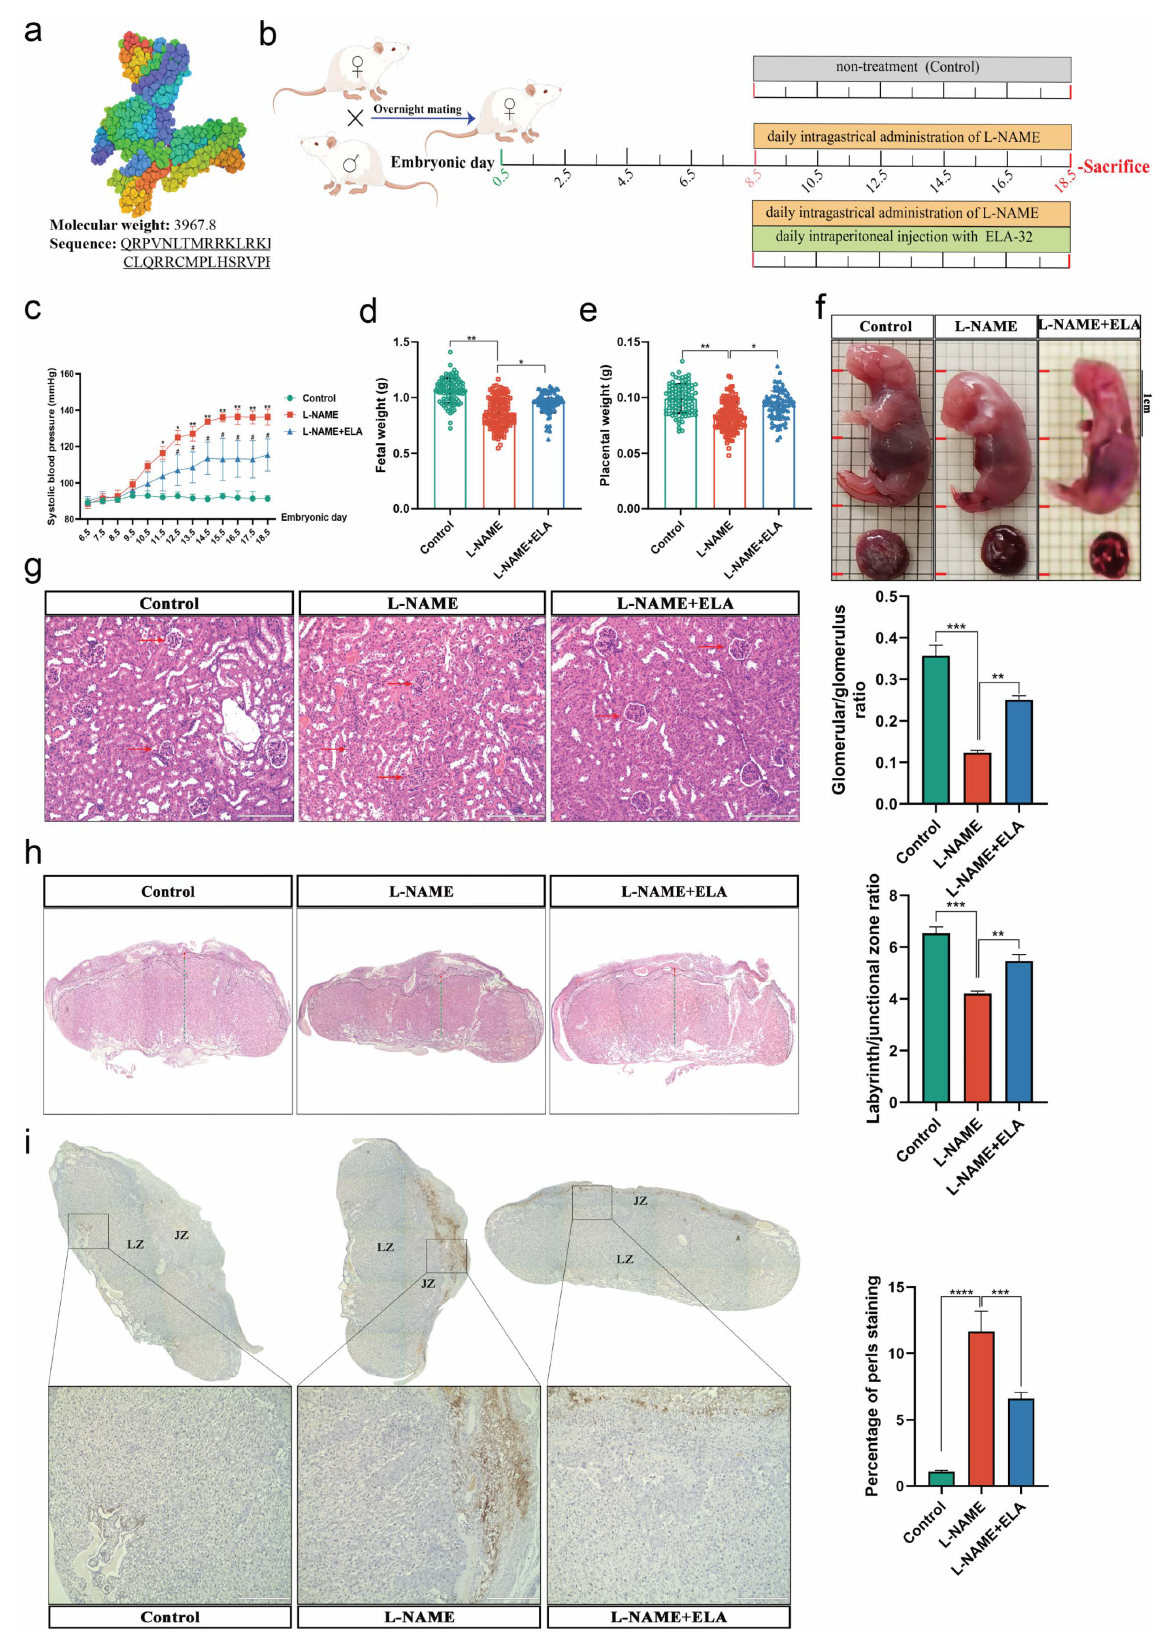
Figure 3. The PE-like and ferroptosis phenotypes in mice were relieved by Elabela administration. ( a ) The biological characteristics of Elabela. ( b ) Schematic illustration of the experimental